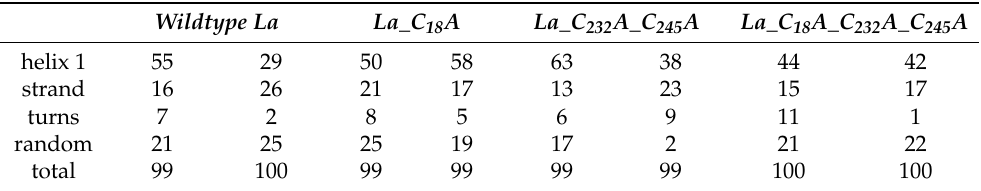
Table 1. Relative secondary structure contributions determined from CD-spectra (Figure 11) with dichroweb (http://dichroweb.cryst.bbk.ac.uk/html/home.shtml). Wildtype La La_C 18 A La_C 232 A_C 245 A La_C 18 A_C 232 A_C 245 A helix 1 55 29 50 58 63 38 44 42 strand 16 26 21 17 13 23 17 random 21 25 25 19 22 total 99 100 99